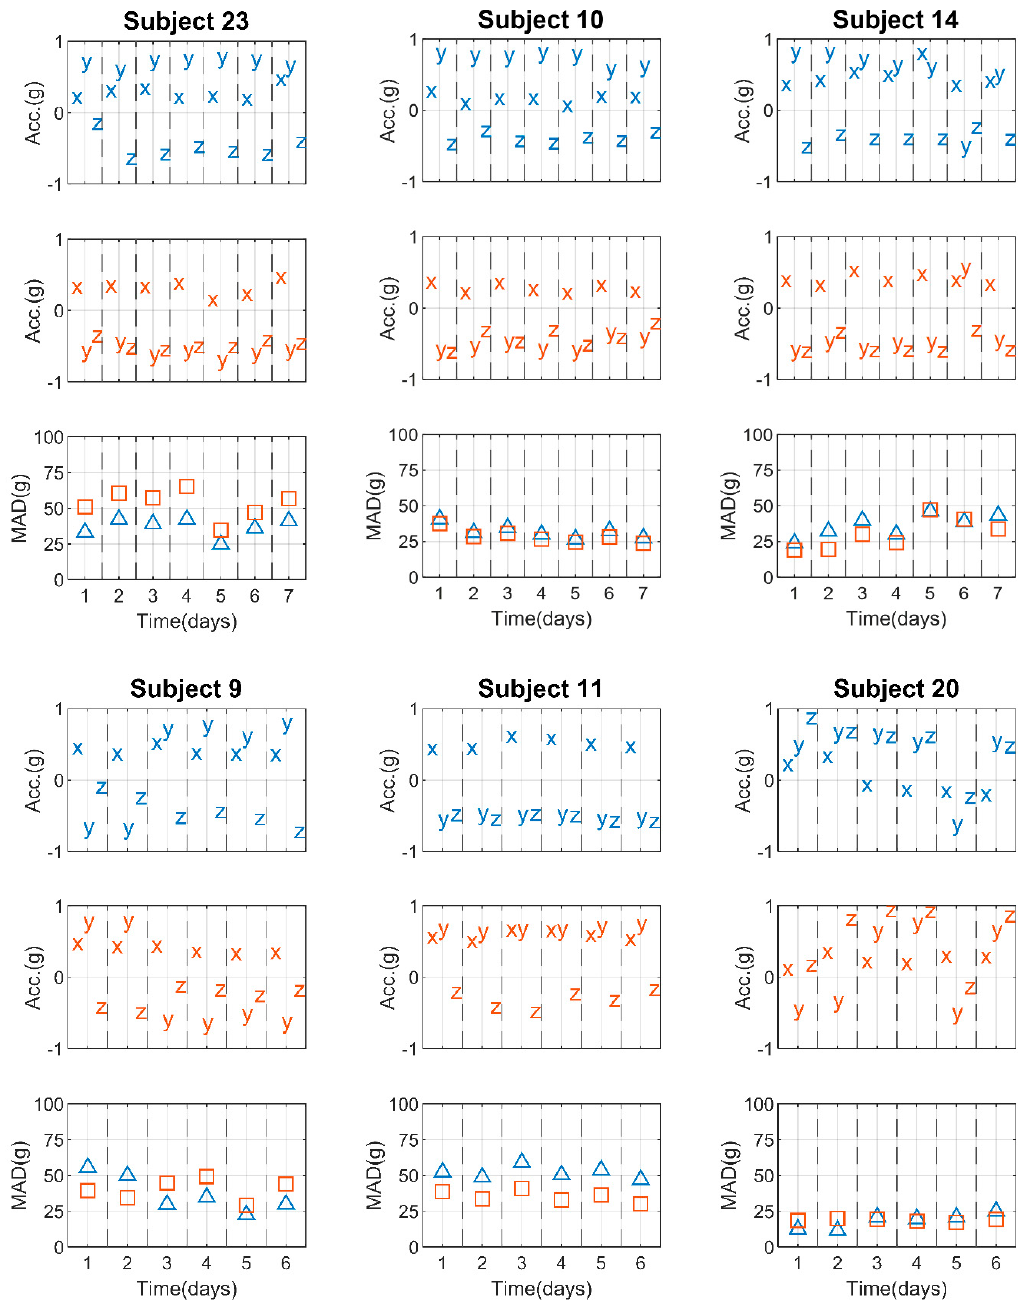
Figure 2. Plots of daily median accelerations of left (blue) and right wrists (red) corresponding to daily summed minute-to-minute MAD (blue triangles and red squares, respectively). The indications are presented for 6 selected participants, where measurements for Subject 23 and 10 were acquired correctly, and measurements for the remaining participants exhibited various discrepancies, primarily the switch of sensor placement from left to right wrist and vice versa for one day (Subject 14), for 2 days (Subject 9 and Subject 20) or for 6 days (Subject 11). Additionally, for Subject 20 the devices were worn in various orientations. Table 2. Intended and actual position of accelerometers during the measurement of Subject 20.